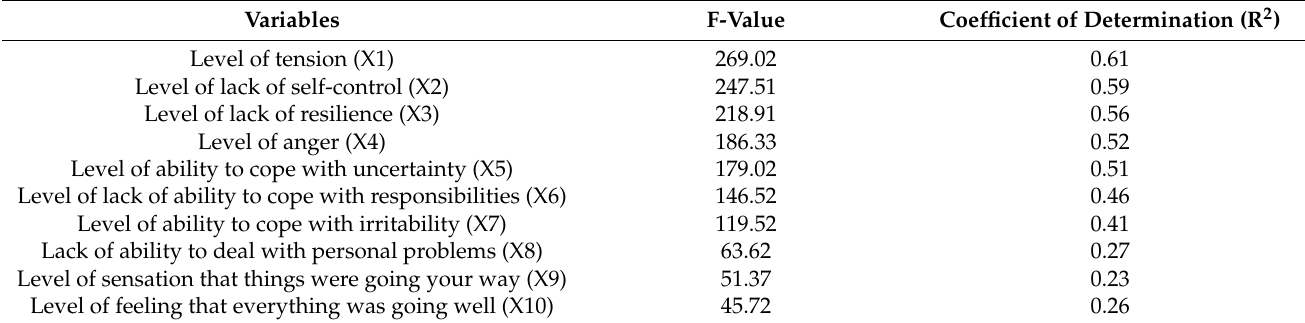
Figure 4. The results of the Kruskal–Wallis test used to assess the significance of the difference values for PSS-10 (sten scale) in relation to the gender of the respondents and the year of study. A simple linear regression model was developed for each independent variable for the PSS-10, as indicated in Table 4. We performed a stepwise regression starting with the independent variable with the highest F-value. The remaining independent variables were added one at a time in the order of the highest F-value. Independent variables were added when adding them improved the model. The improvement of the model was determined by increasing the R 2 value. Table 4. F-value and coefficient of determination for each independent variable.